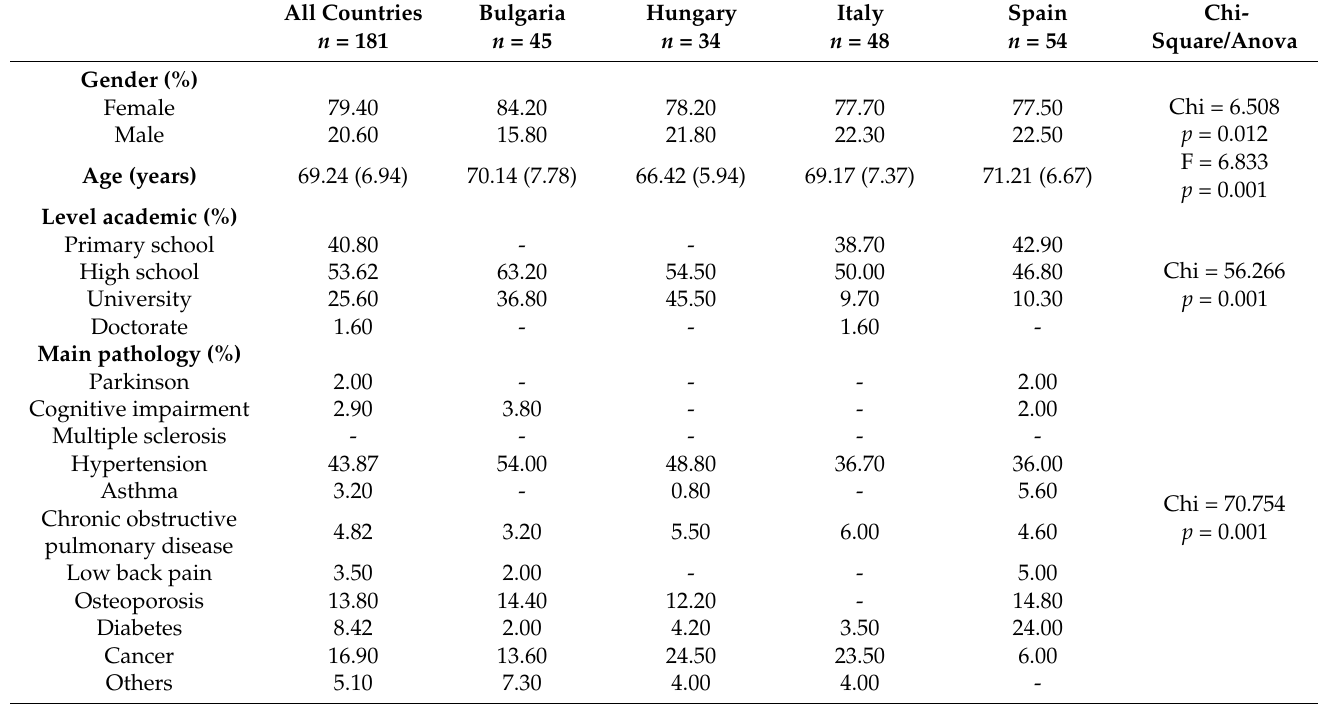
Table 1. Sample Characteristics by